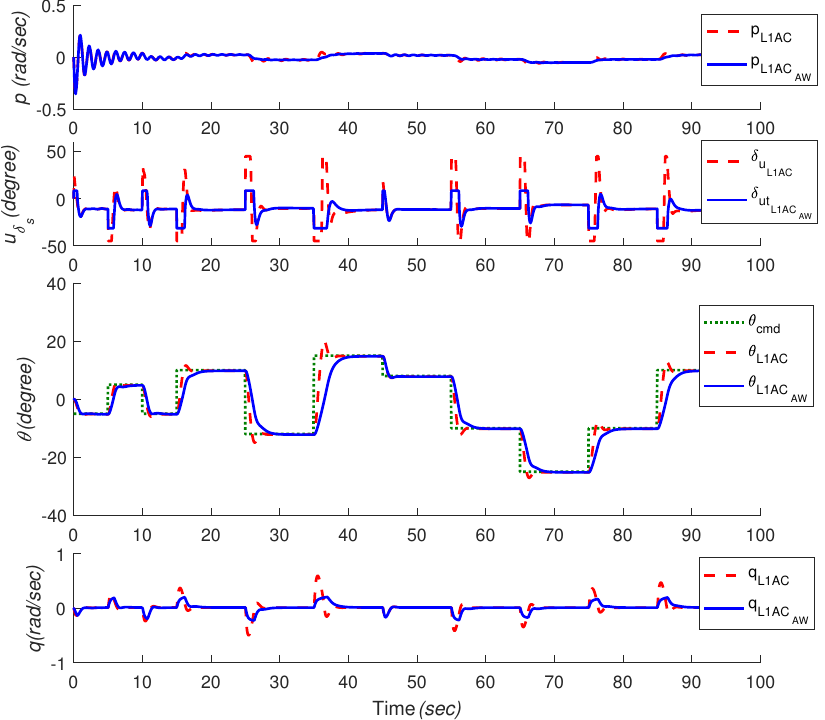
Figure 7. Pitch channel control in the presence of the actuator saturation for REMUS six DOF model tracking θ cmd with different